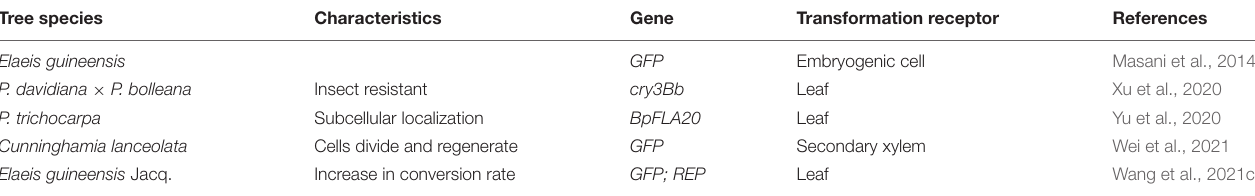
TABLE 5 | Protoplast transformation in different tree species. Tree